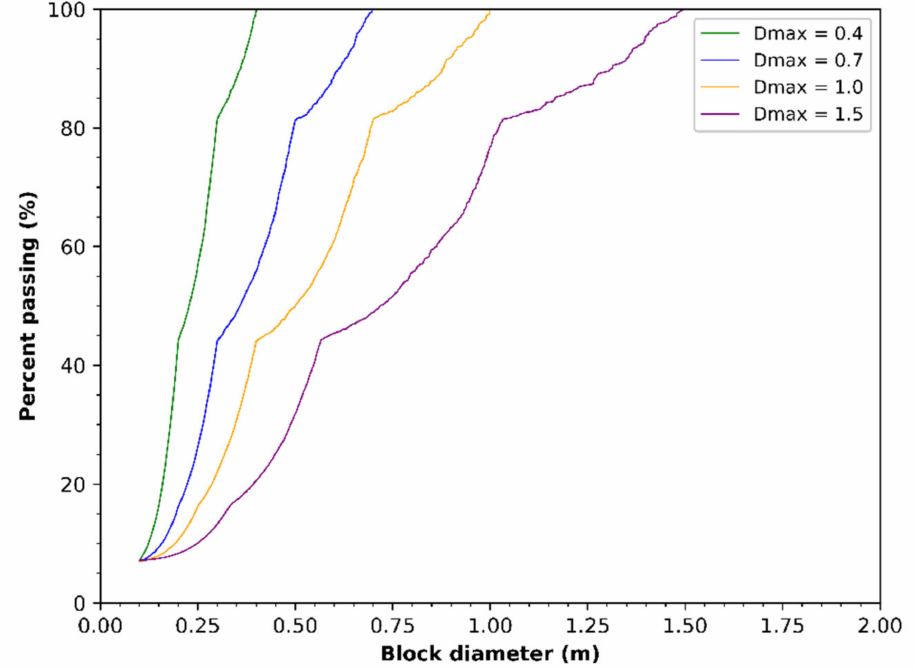
Figure 1. Particle size distributions of blocks in the debris